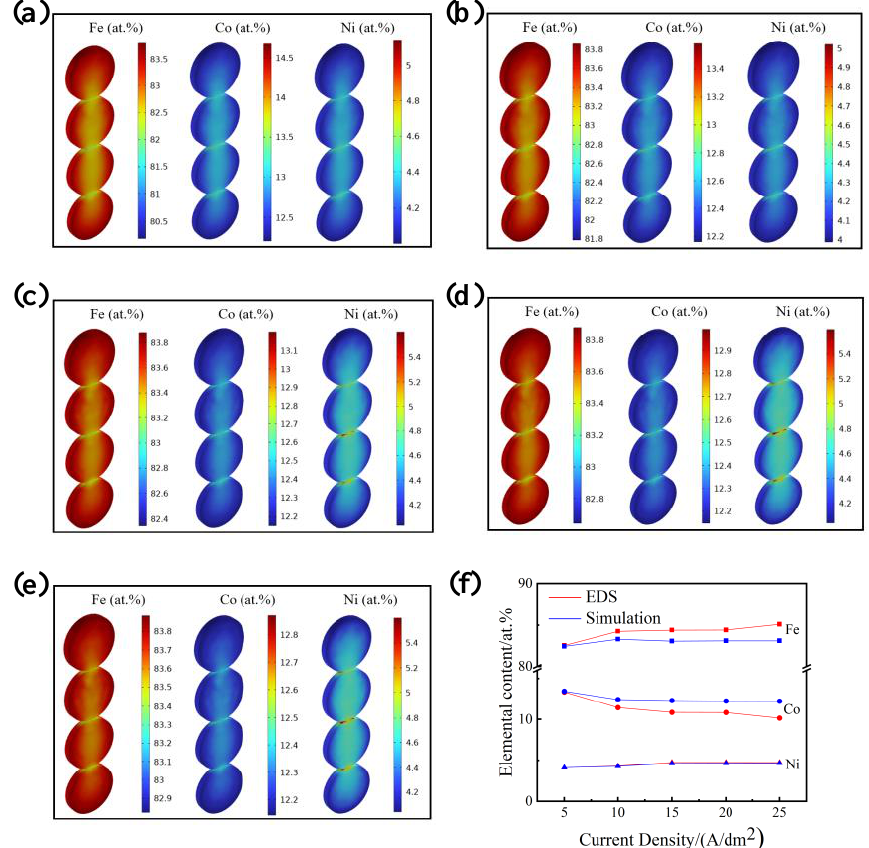
Figure 5. Simulated elemental content in electrodeposited coatings at current densities of ( a ) 5 A/dm 2 , ( b ) 10 A/dm 2 , ( c ) 15 A/dm 2 , ( d ) 20 A/dm 2 , and ( e ) 25 A/dm 2 ; ( f ) comparison between simulation and experimental